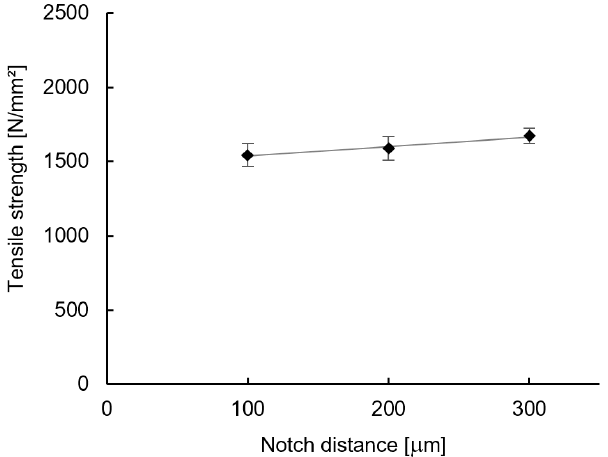
Figure 9. Average values of tensile strength and standard deviation for z-pinned unidirectional carbon/epoxy composites reinforced with circumferentially notched z-pins with rectangular notch design with constant notch depth of 20 µ m in dependency of the notch distances.